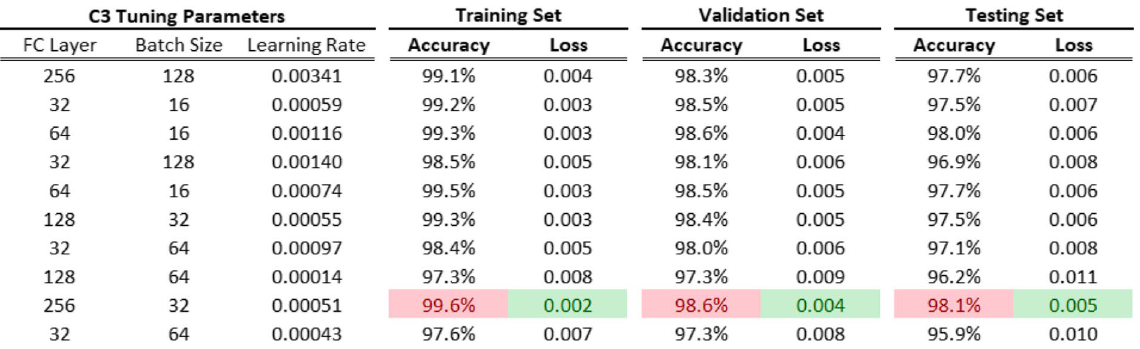
Table 7 Hyperparameter tuning for C3